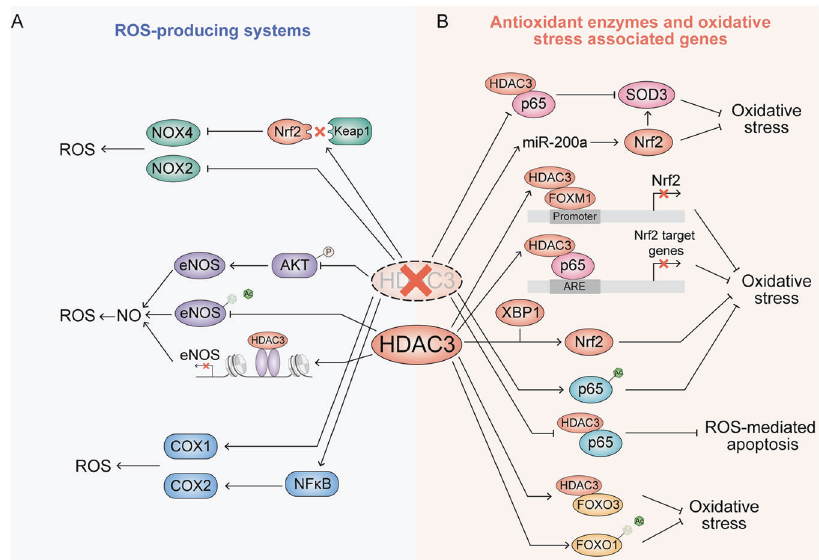
Fig. 4 HDAC3 regulation oxidative stress-associated enzyme and genes. A HDAC3 regulates the enzymes responsible for ROS production. B HDAC3 regulates antioxidant enzymes and oxidative stress-associated transcription